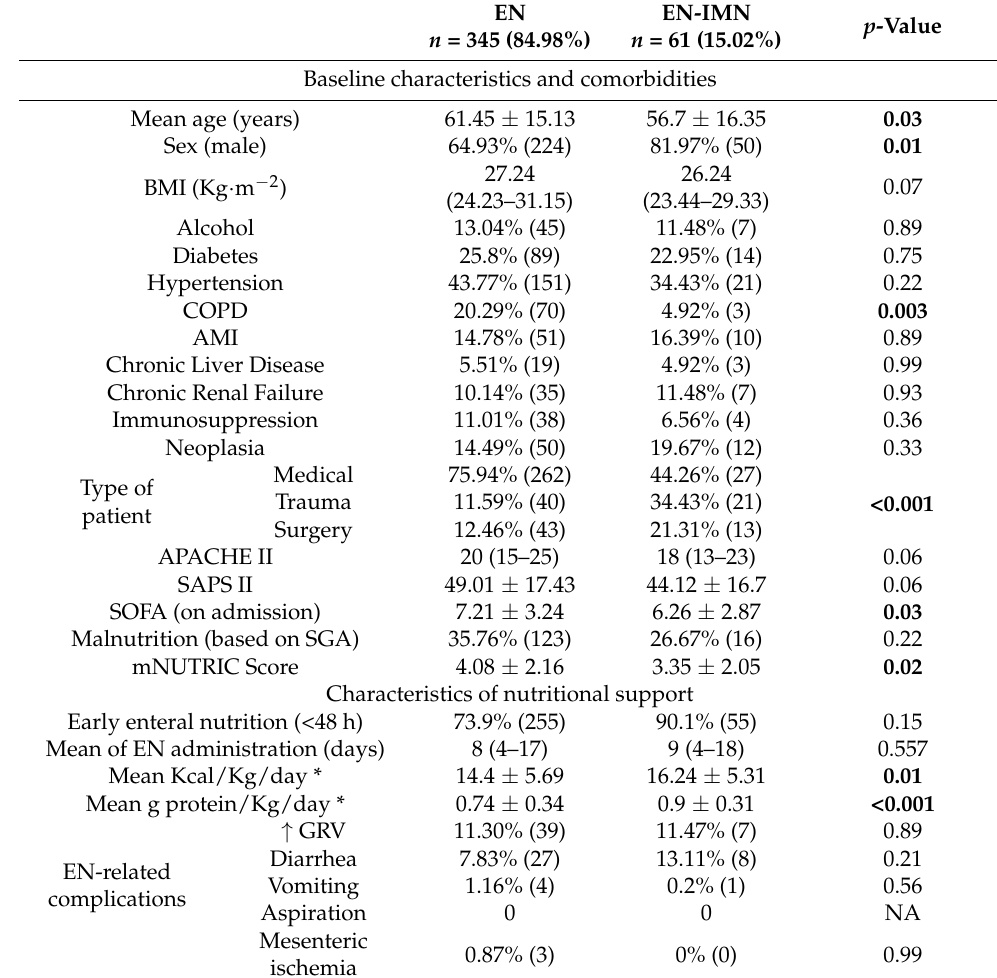
Table 2. Differences among patients receiving immunonutrition formulas and other types of enteral